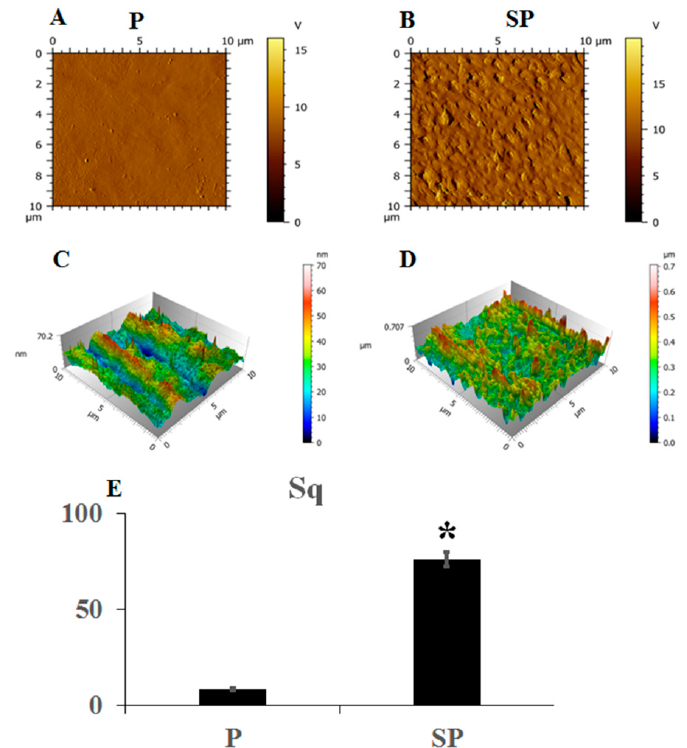
Figure 3. Atomic force microscopy (AFM) images of peek specimens ( A ) P and ( B ) SP. Three-dimensional fluctuating images of peek specimens ( C ) P and ( D ) SP for comparison of the surface roughness. * p < 0.05.